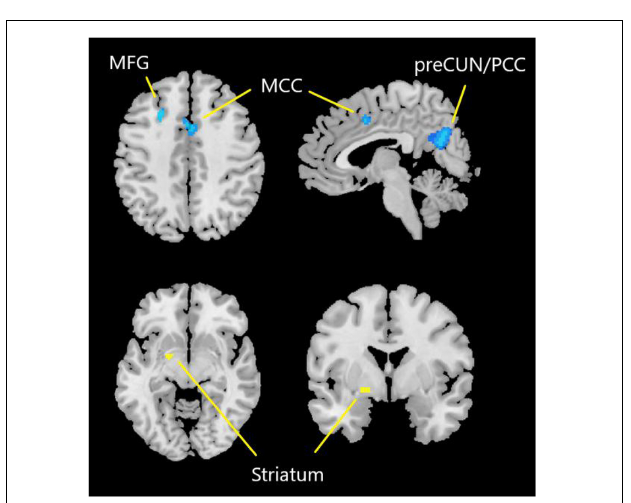
FIGURE 2 | Flow diagram shows the experiment designing of the current study.